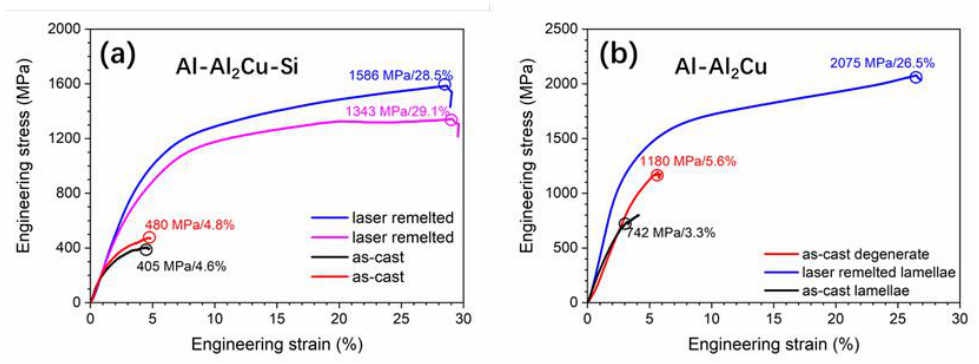
Figure 2. Compressive engineering stress—engineering strain curves of micropillars with different microstructures: ( a ) Al–Al 2 Cu–Si eutectic; ( b ) Al–Al 2 Cu eutectic. The strain to fracture and the maximum compress flow stress before fracture are presented.